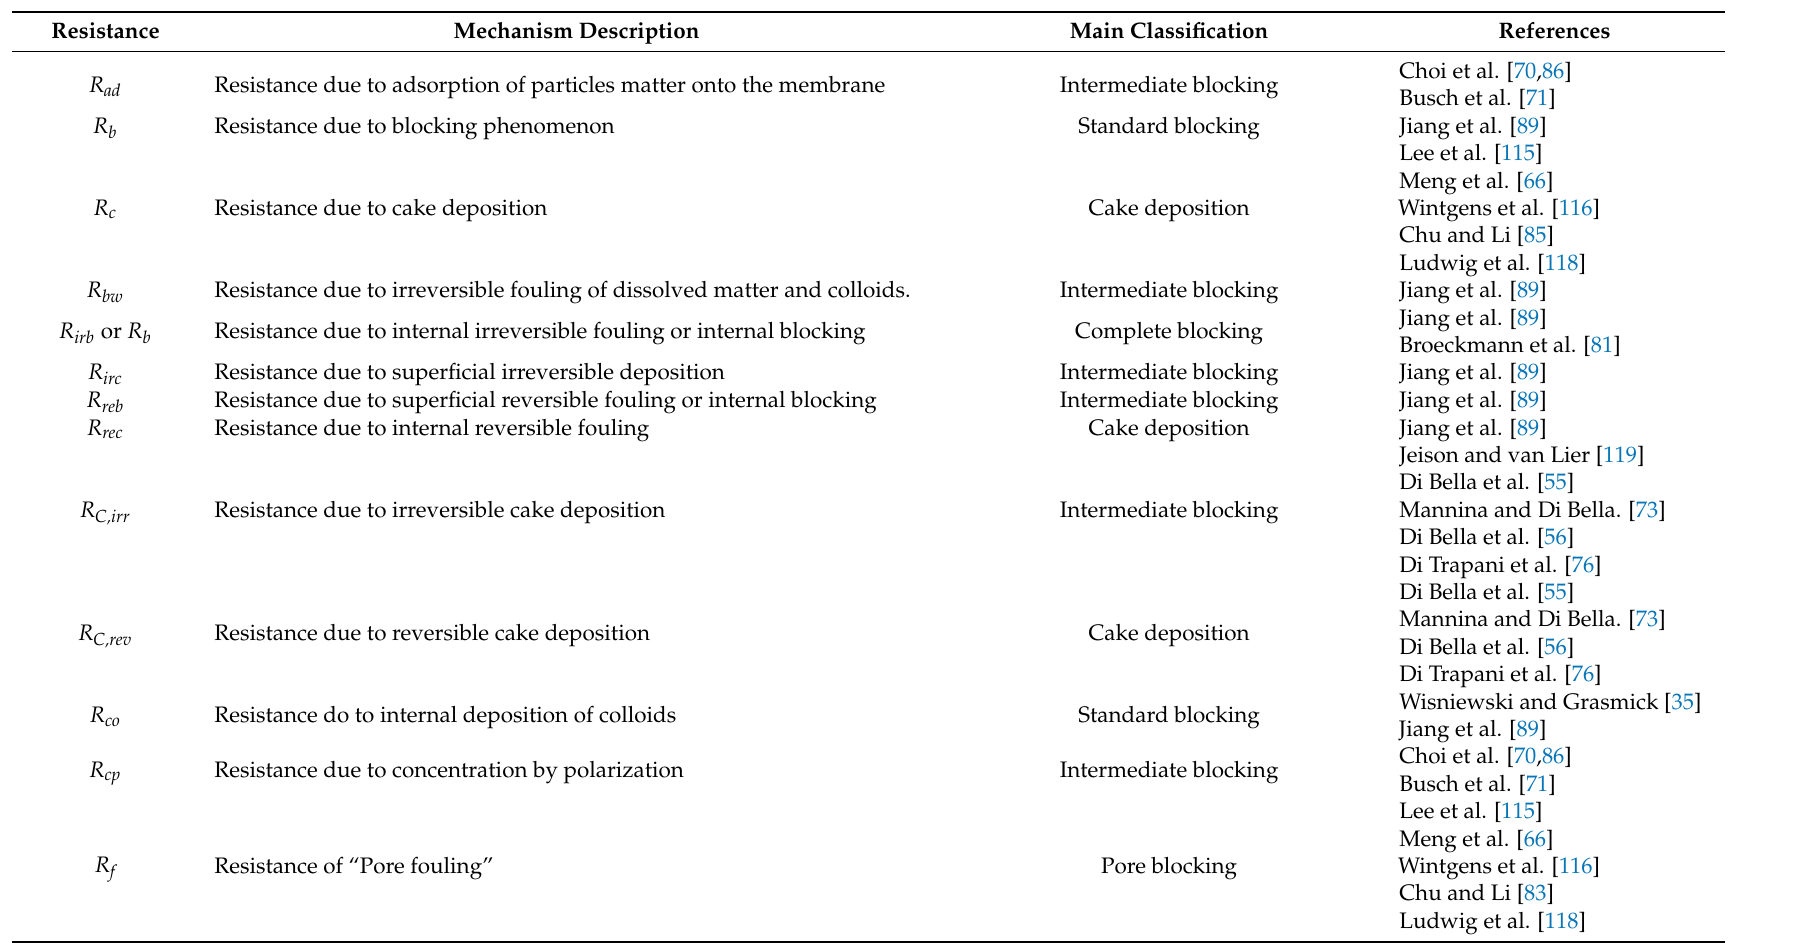
Table 1. Specific resistances used in the total resistance